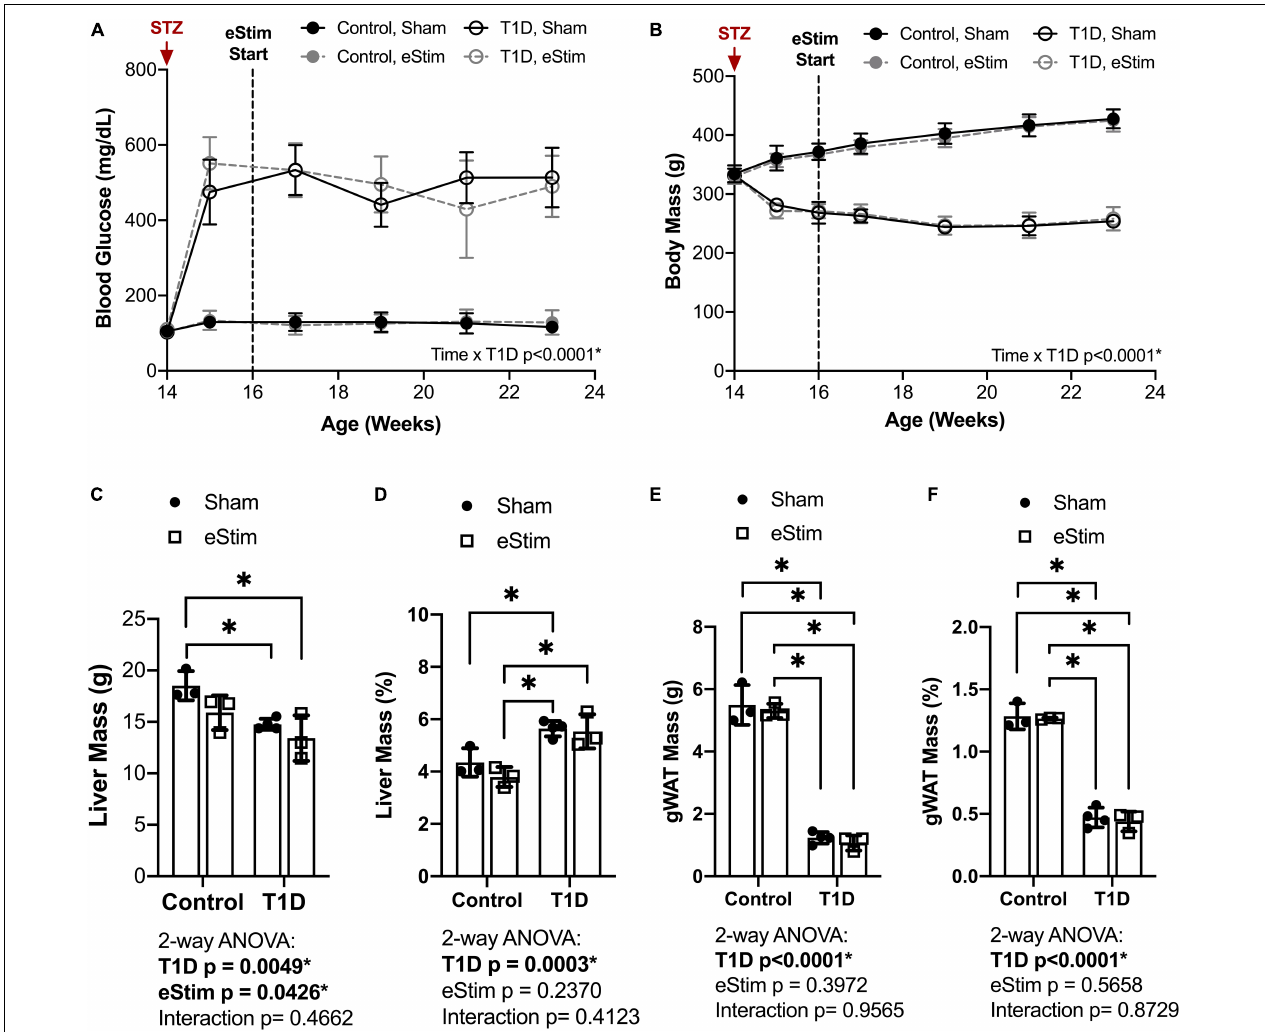
FIGURE 2 | Blood glucose and body and organ mass. Blood glucose and body mass were evaluated starting at the time of STZ induction (14-week of age) up to the final week of treatment (24-week of age). (A) Blood glucose. (B) Body mass. (C) Liver mass at end point. (D) Liver mass normalized to body mass. (E) Gonadal white adipose tissue (gWAT) mass at end point. (F) gWAT mass normalized to body mass. Statistics for blood glucose and body mass were performed by mixed effects and three-way ANOVA analyses, respectively, as a single missing value was present in the blood glucose data; Control, sham n = 7; Control, eStim n = 6; Diabetic, sham n = 8; Diabetic, eStim n = 5; * p < 0.050. Statistics for organ masses was performed by two-way ANOVA with Sidak’s multiple comparisons test; Control, sham n = 3; Control, eStim n = 3; Diabetic, sham n = 4; Diabetic, eStim n = 3; * p <